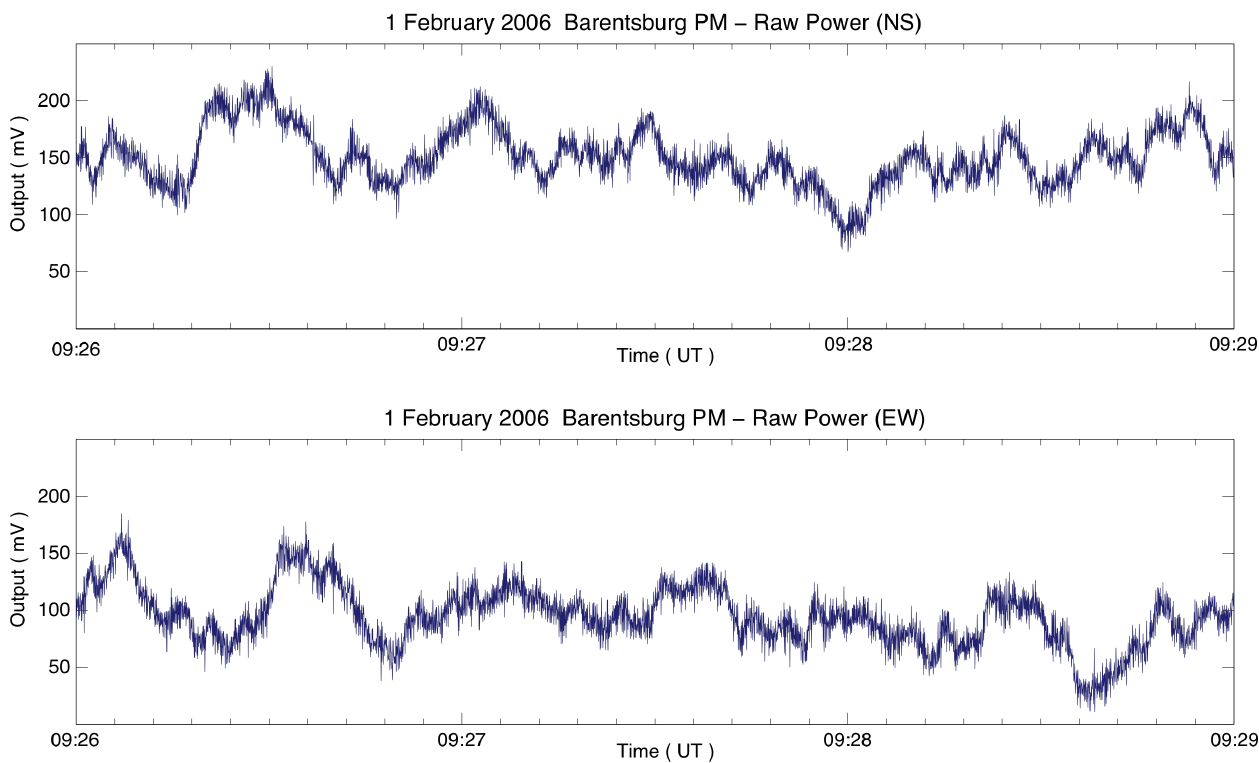
Fig. 9. Raw time domain output of the Barentsburg pulsation magnetometer. The upper panel is for the north-south inductor, the lower for the